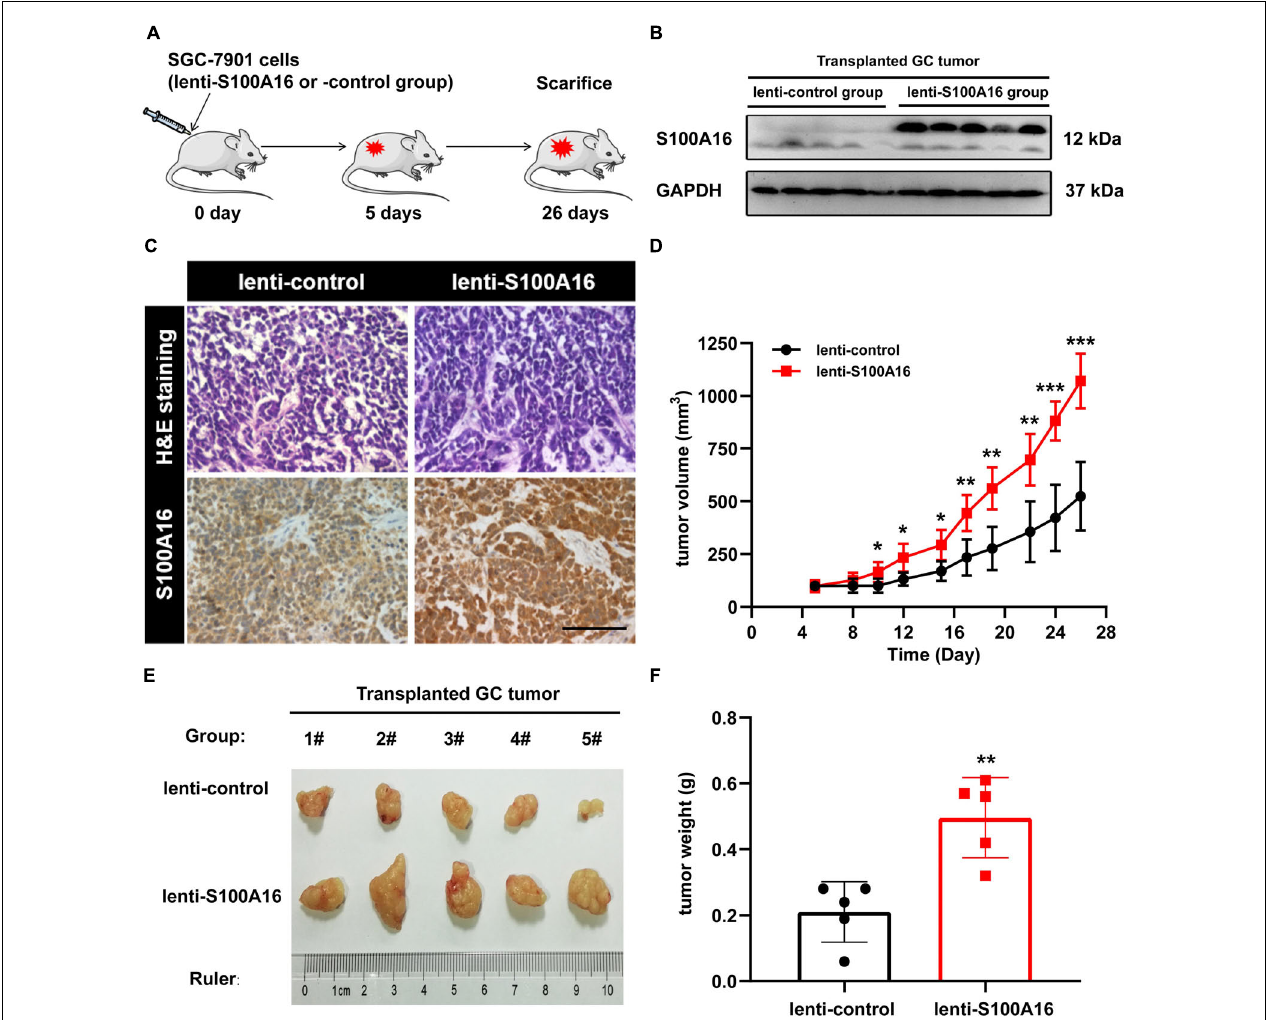
FIGURE 4 | Overexpression of S100A16 enhances GC cells tumorigenesis in vivo . (A) Diagram of subcutaneous tumor transplantation in nude mice. (B,C) S100A16 overexpression were confirmed by Western blotting (B) and immunohistochemistry (C) in transplanted tumor tissues formed by SGC-7901 cells. Scare bar = 200 µ m. (D) The volume for transplanted GC tumor was measured every 4-5 days since 5 d after injection. (E,F) The size and weight for xenograft tumors after sacrificed. Data are presented as mean ± SD. N = 5 for each group. For panels (D,F) , * P < 0.05, ** P < 0.01, and *** P < 0.001 vs. lenti-control